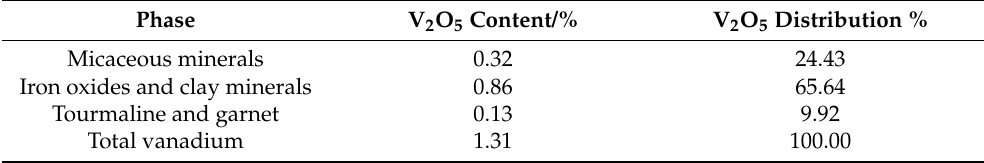
Table 4. Phase analysis of vanadium in the stone